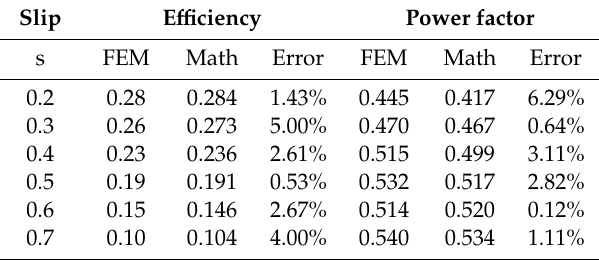
Table 4. E ffi ciency and power Table 4. Efficiency and power factor.